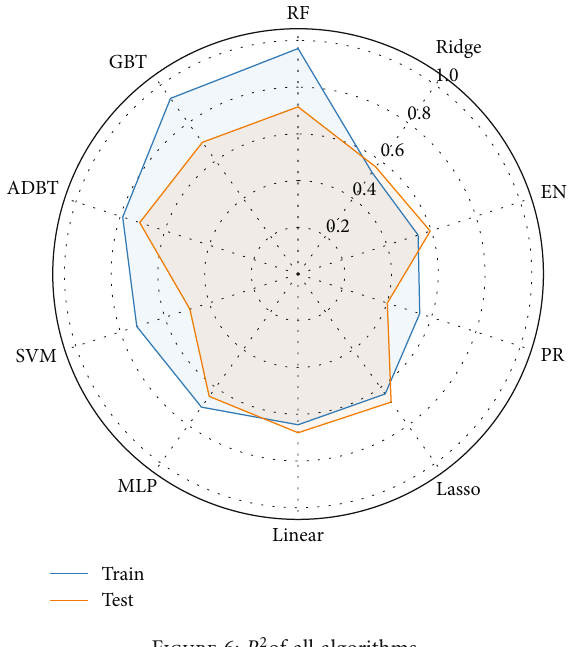
Figure 6: R 2 of all Table 2: R 2 of all algorithms ’ train and test.